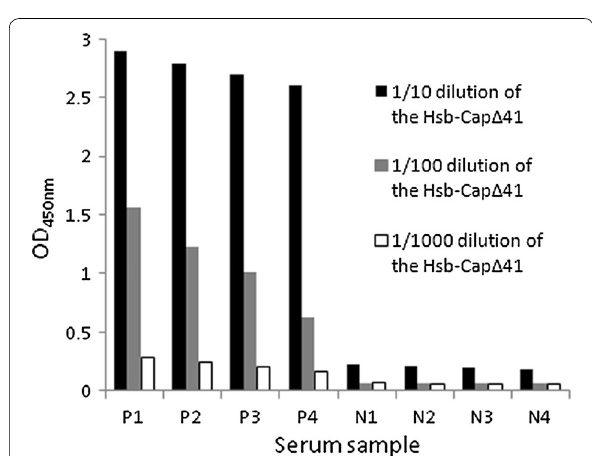
Fig. 3 Reactivity of Hsb‑Cap∆41 with PCV2 positive and PCV2 negative sera. P1 – P4 4 PCV2 positive serum samples. N1 – N4 4 PCV2 negative serum